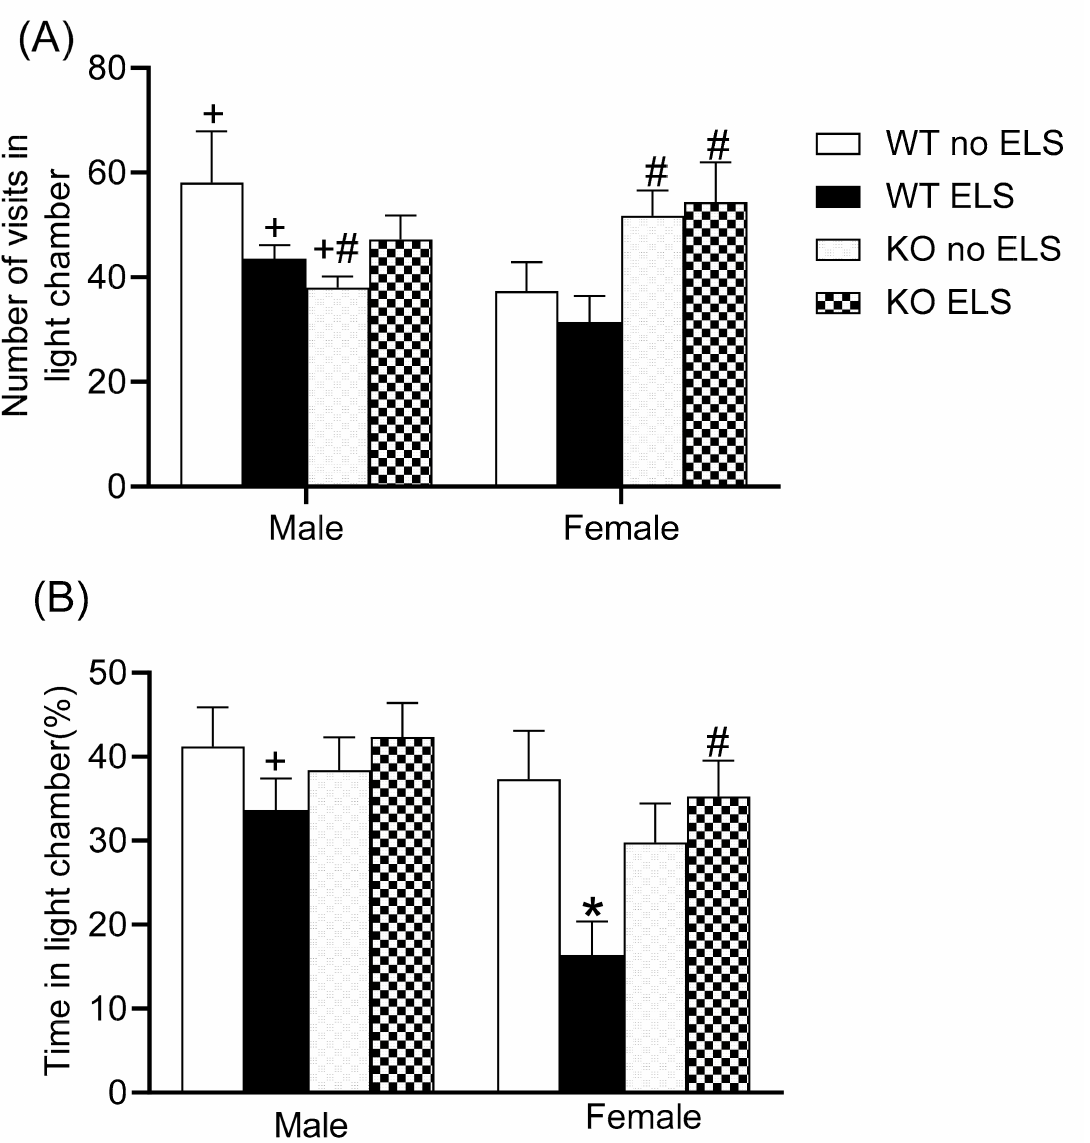
Figure 3. Effect of early life stress on WT and GPR37KO mice on light-dark box test. Frequency in light chamber ( A ). Percentage time spent in light chamber ( B ). N/group: WT no-ELS male = 8, WT ELS male = 7, KO no-ELS male = 10, KO ELS male = 10, WT no-ELS female = 8, WT ELS female = 7, KO no-ELS female = 9 and KO ELS female = 9. All data represent mean ± SEM. * p < 0.05 treatment difference within genotype; # p < 0.05 versus corresponding WT; + p < 0.05 with respect to sex; calculated by three-way ANOVA followed by multiple comparisons using the two-stage linear step-up procedure of Benjamini, Krieger and Yekutieli. WT = Wild Type, KO = Knockout, ELS = Early Life